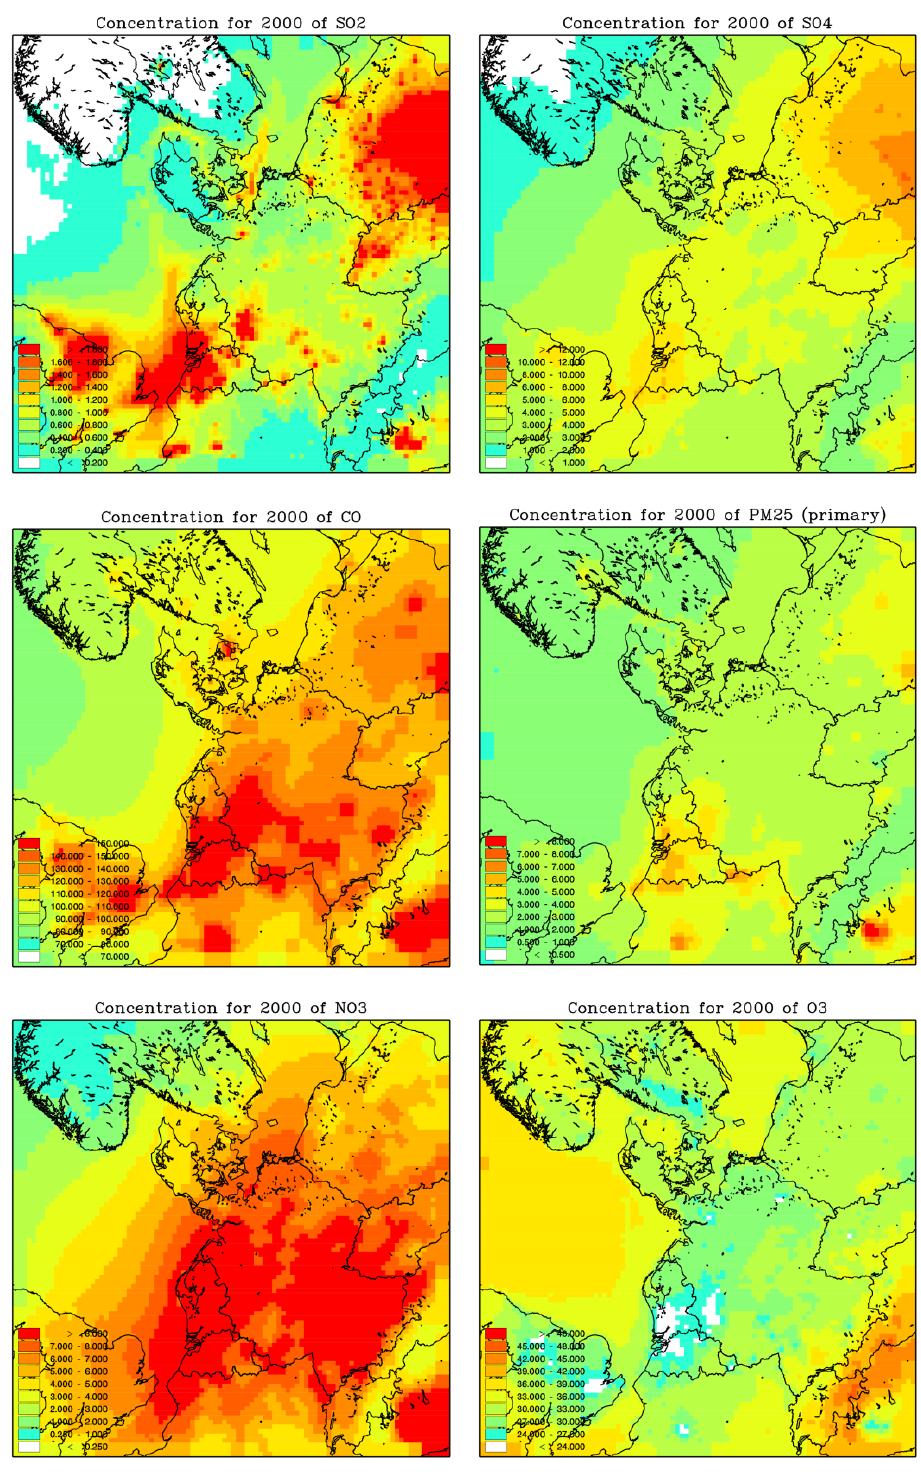
Figure 3: 4 Fig. 3. As Fig. 1, but for DEHM northern European model